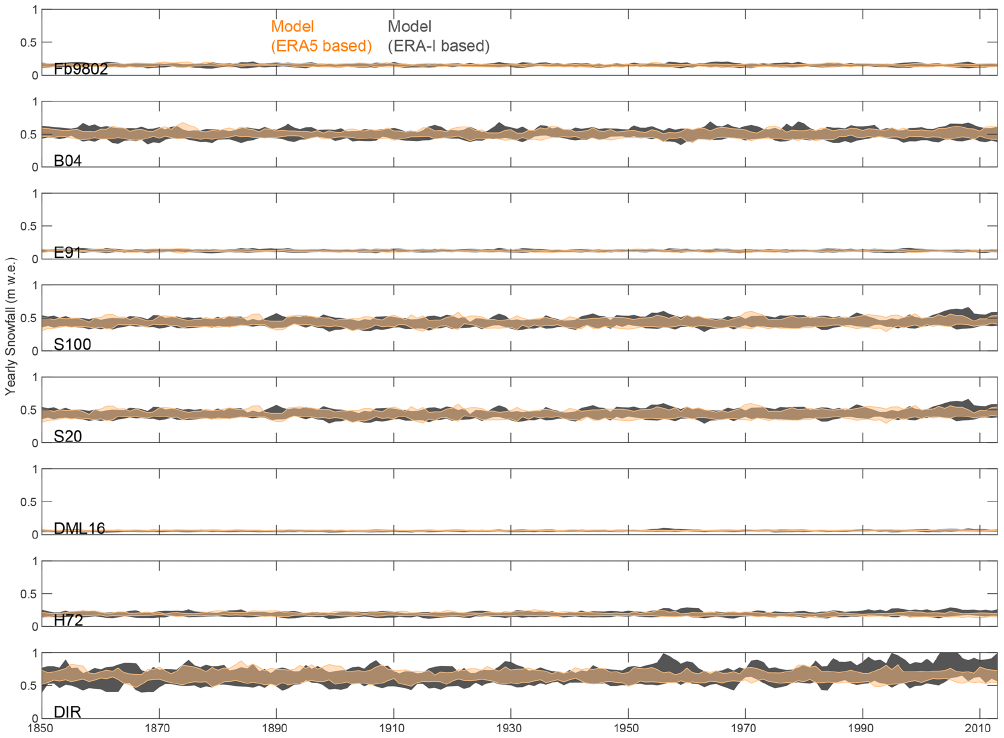
Figure 12. The difference between CESM2 downscaling using ERA-Interim and ERA5 in the training reveals an uncertainty of 25% on average at the ice core